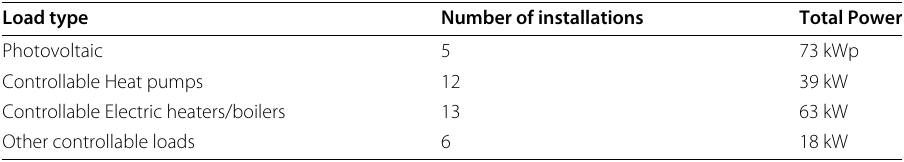
Table 1 Characteristics of the installations in the LIC area